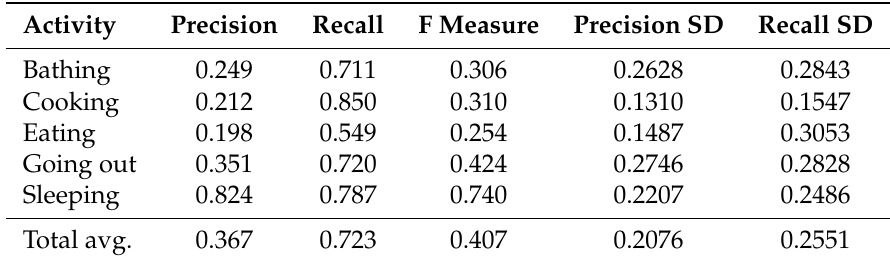
Table 4. Metrics of activity